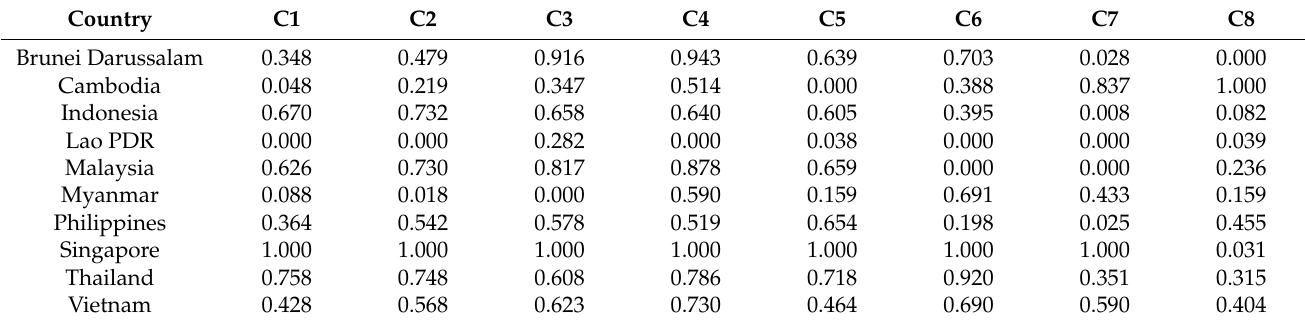
Table 4. Under-risk utility matrix with risk coefficient = 0.88.